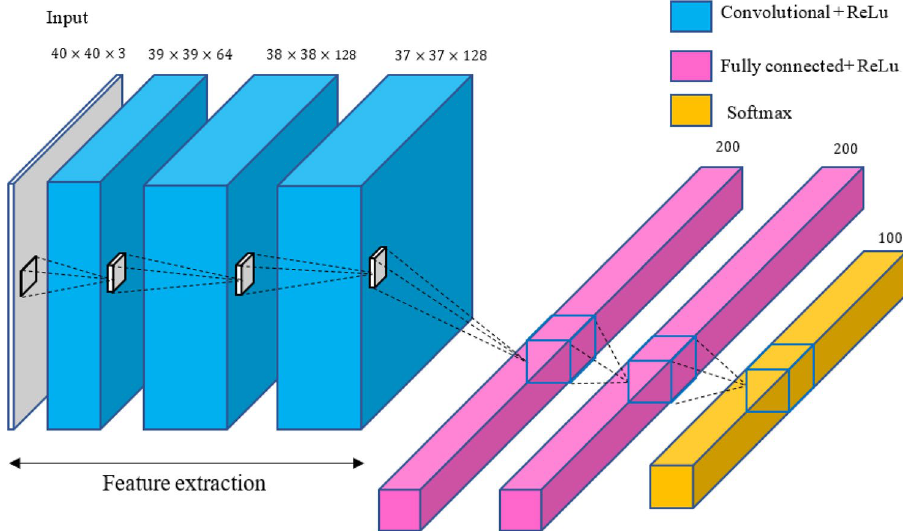
Figure 3. The convolutional neural network architecture in the proposed method.